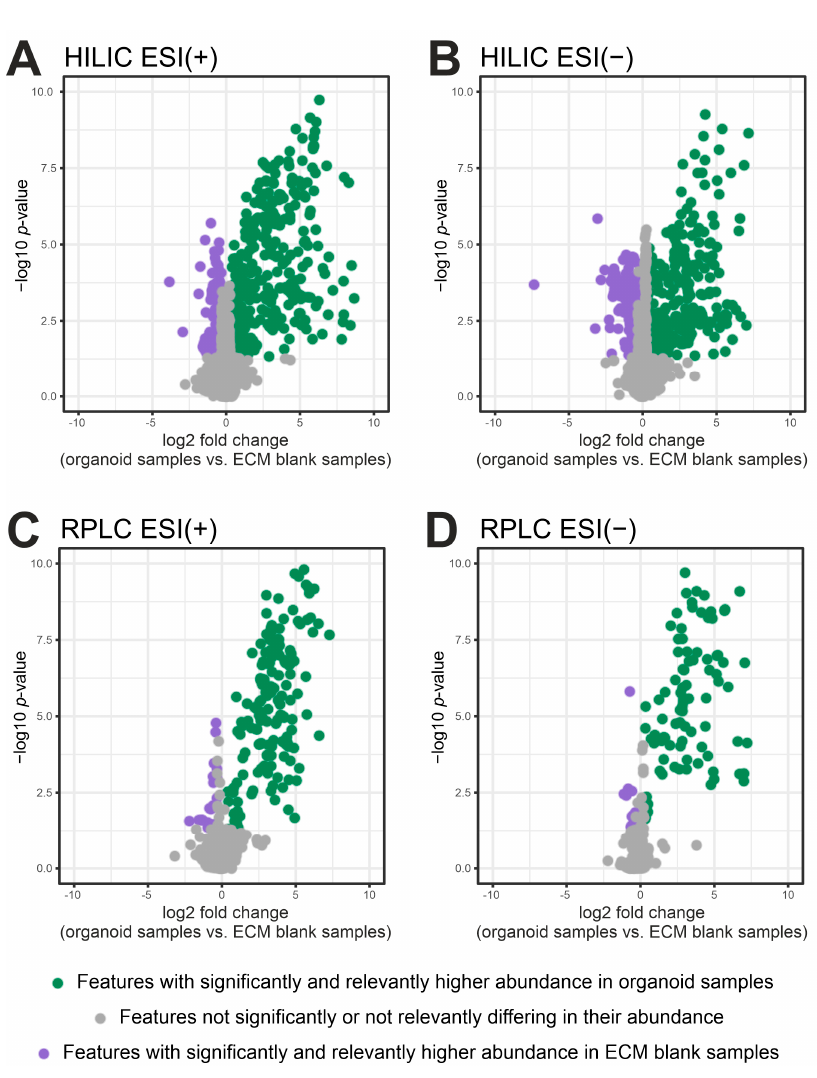
Figure 2. Volcano plots comparing the abundance of features detected in organoid samples ( n = 5) and ECM-blank samples ( n = 3): ( A ) HILIC ESI ( + ) mode; ( B ) HILIC ESI ( − ) mode; ( C ) RPLC ESI ( + ) mode; ( D ) RPLC ESI ( − ) mode. Features with significantly and relevantly higher abundance in organoid samples (fold change (FC) > 1.2, p < 0.05, HILIC ESI ( + ) / ( − ): 311 / 299 features and RPLC ESI ( + ) / ( − ): 149 / 92 features) are colored in green and are considered to be cell derived. Features with significantly and relevantly higher abundance in ECM-blank samples (FC < 0.8, p < 0.05, HILIC ESI ( + ) / ( − ): 113 / 117 features and RPLC ESI ( + ) / ( − ): 25 / 13 features) are colored in purple. Grey dots represent features not significantly or not relevantly di ff ering in their abundance (HILIC ESI ( + ) / ( − ): 1170 / 735 features and RPLC ESI ( + ) / ( − ): 406 / 217 features). Purple and grey features were considered to represent uninformative background signals and were removed prior to subsequent statistical